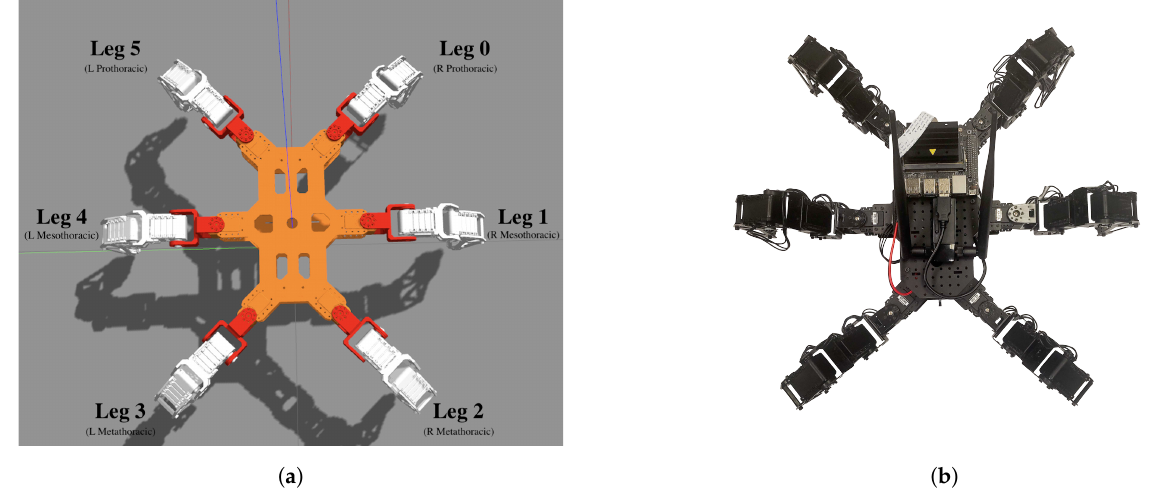
Figure 1. Trossen Robotics PhantomX hexapod ( a ) leg enumeration, rendered and simulated in ROS Gazebo ( b ) physical implementation of hexapod robot. For alternating tripod gaits odd enumerated legs move separately from even